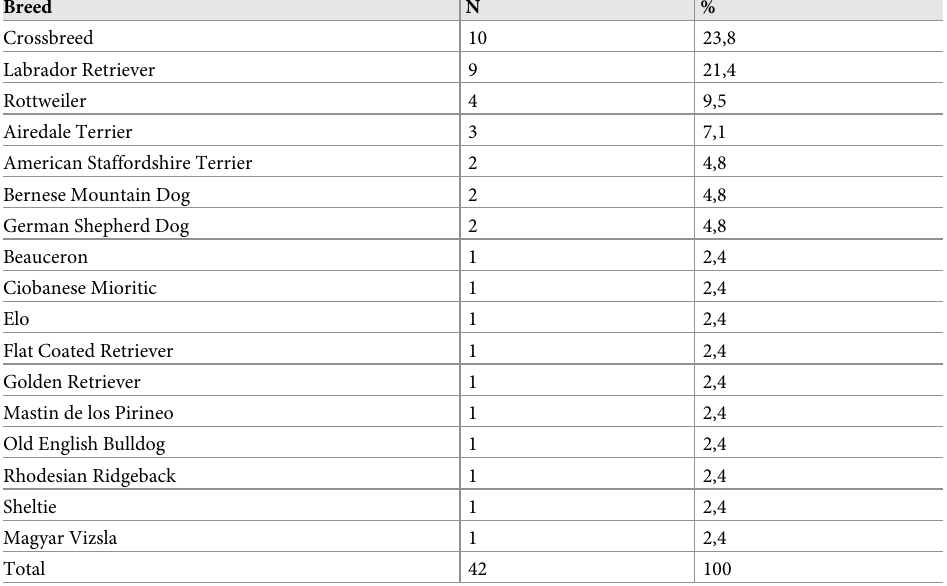
Table 3. Number of